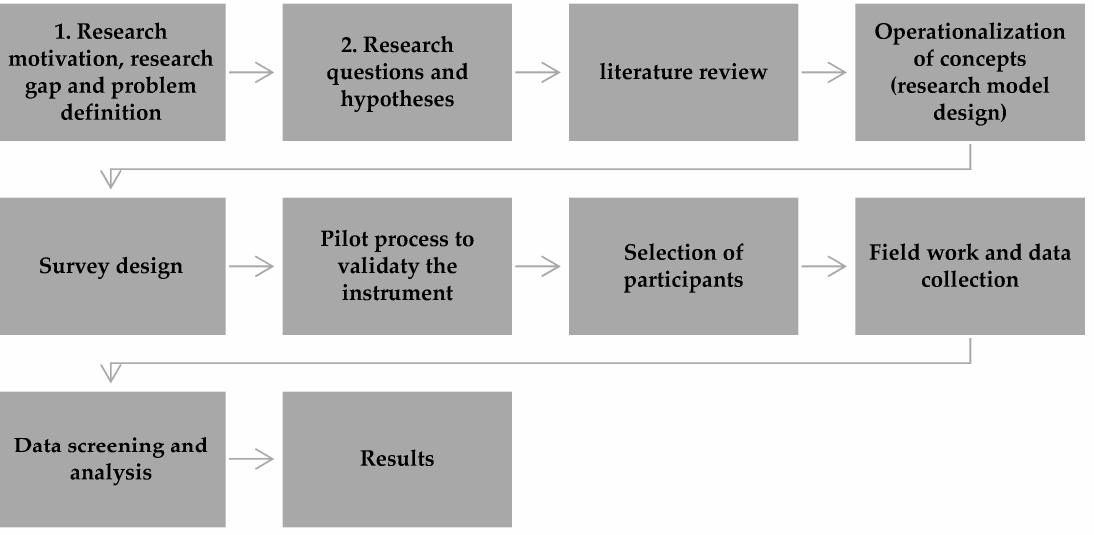
Figure 3. Graphical representation of the research methodology.